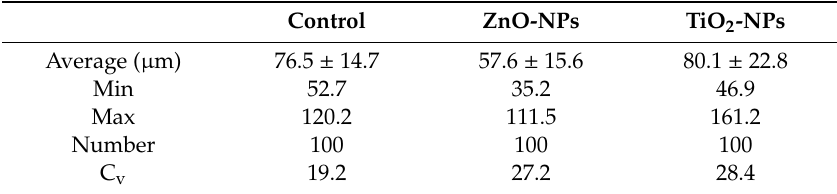
Table 5. Tukey HSD average µ m widths at α = 0.01 for non-glandular trichomes on leaves collected during flower-bud formation after two foliar TiO 2 -NPs and ZnO-NPs applications and the NP-free control (Min—minimum, Max—maximum, C v —coe ffi cient of variation).